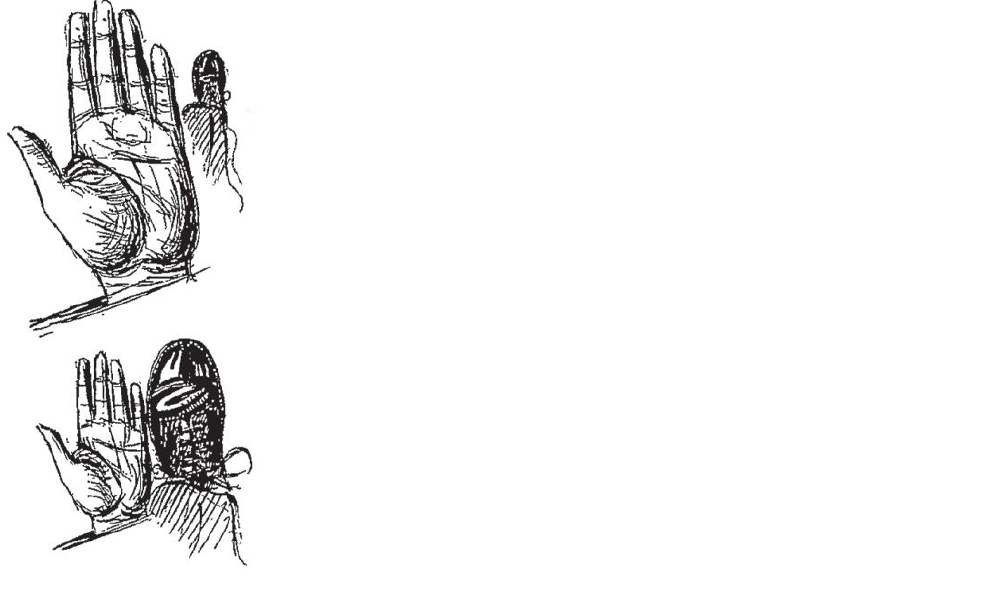
Figure 3. The subjective private view and the objective public view [8] (p. 171). Reproduced with permission of the Shollond Trust.